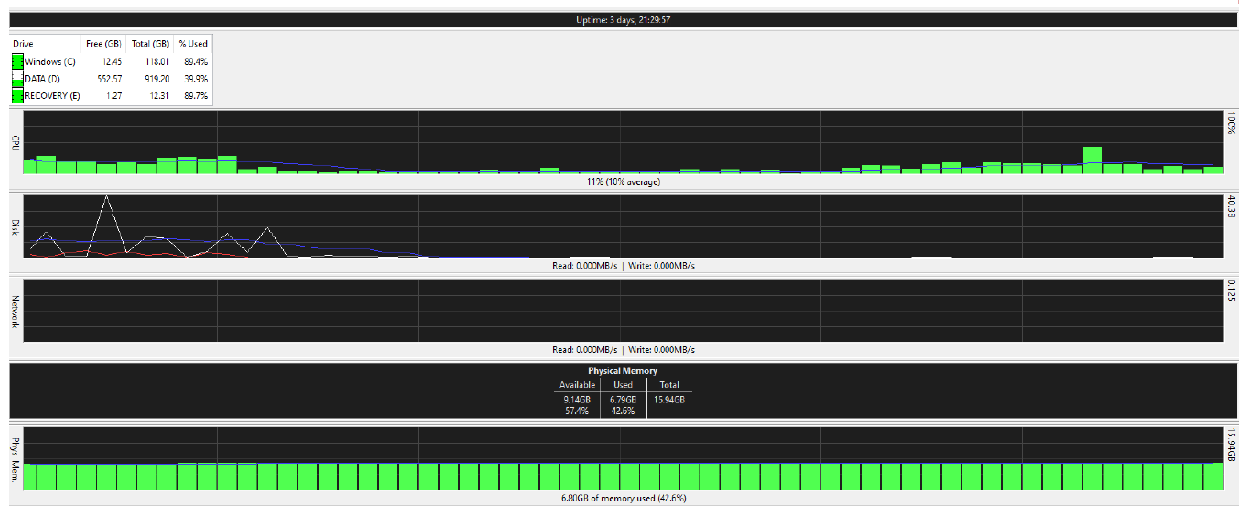
Figure 28. Running the monitoring tool after the application is in process (regular node) Windows machine.